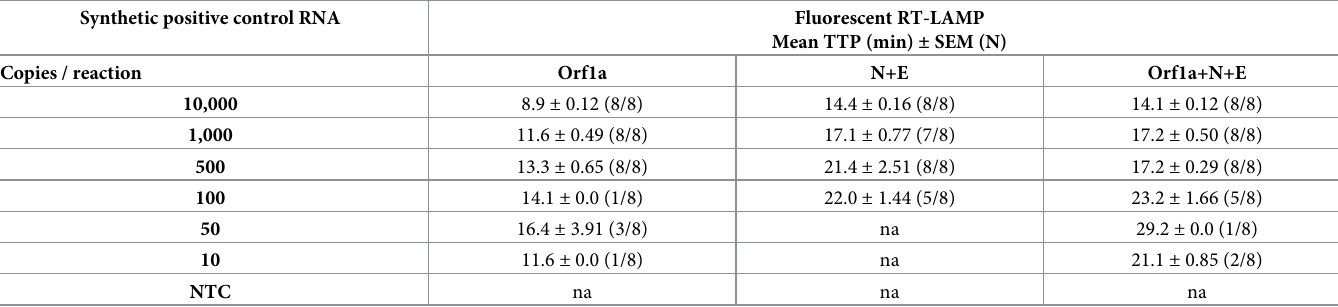
Table 2. Limit of detection of fluorescent end-point RT-LAMP reactions. Synthetic positive control RNA